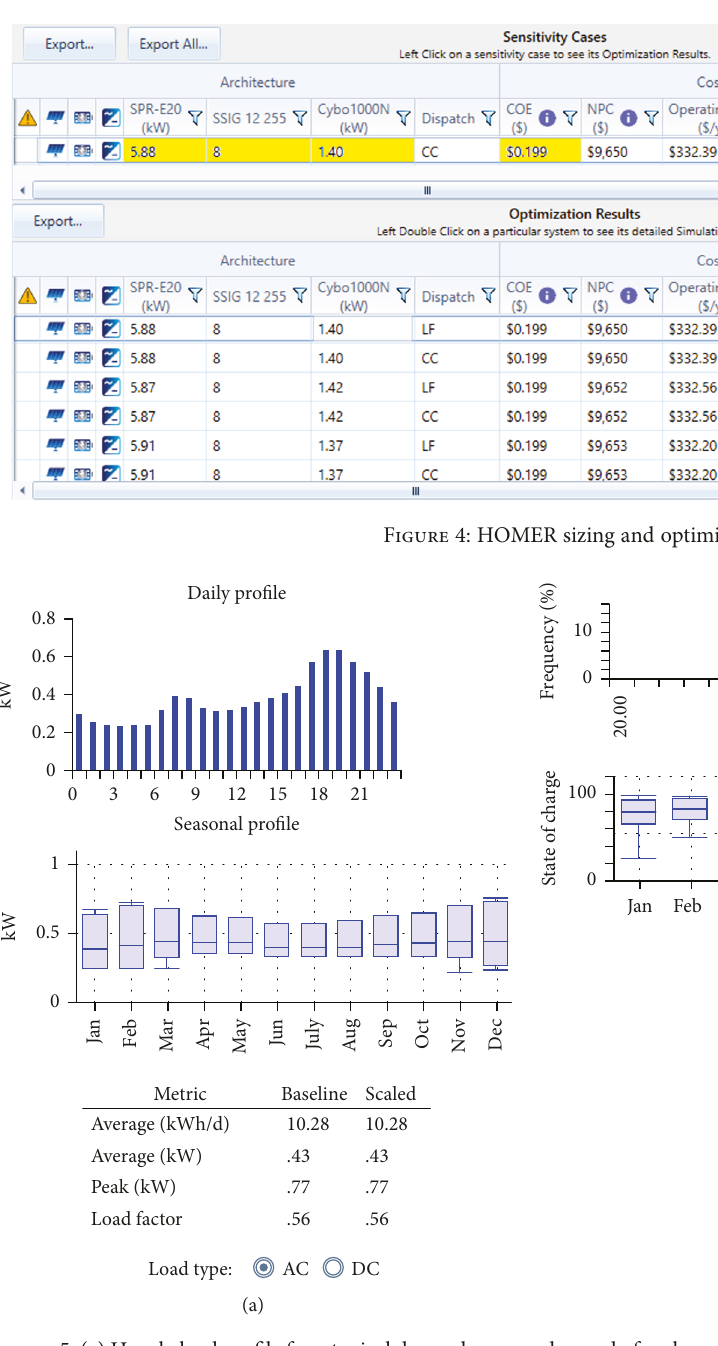
Figure 5: (a) Hourly load pro fi le for a typical day and average demand of each month. (b) Battery bank discharge frequency and the depth of discharge. Table 2: Project estimated costs